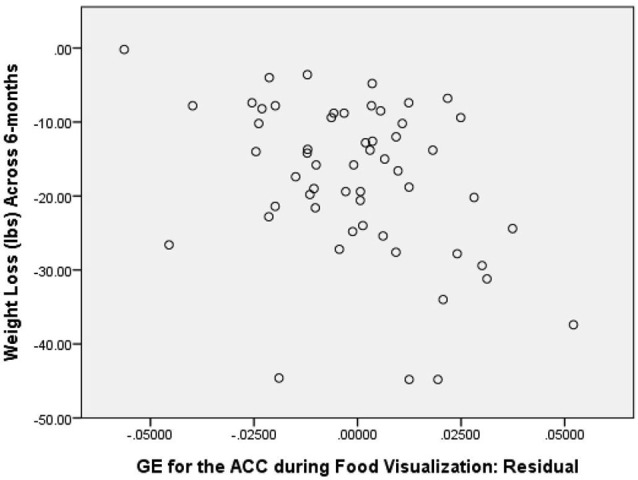
Correlation between GE of the ACC during Food Visualization, Residualized for Covariates, and 6-Month Weight Loss.